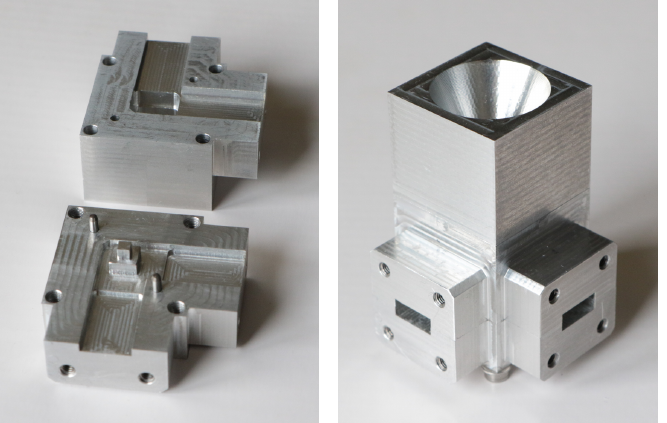
Figure 2. Manufactured very compact dual-probe waveguide OMT prototype: separated parts ( left ) and assembled parts, including the conical horn for test purposes ( right ).